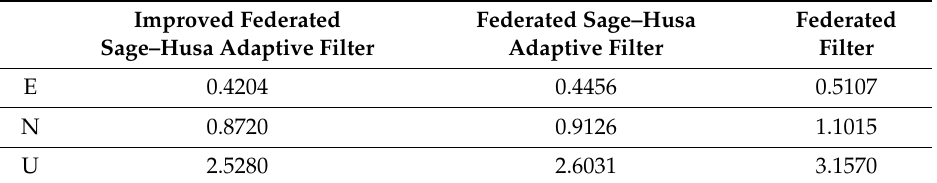
Table 6. Velocity error